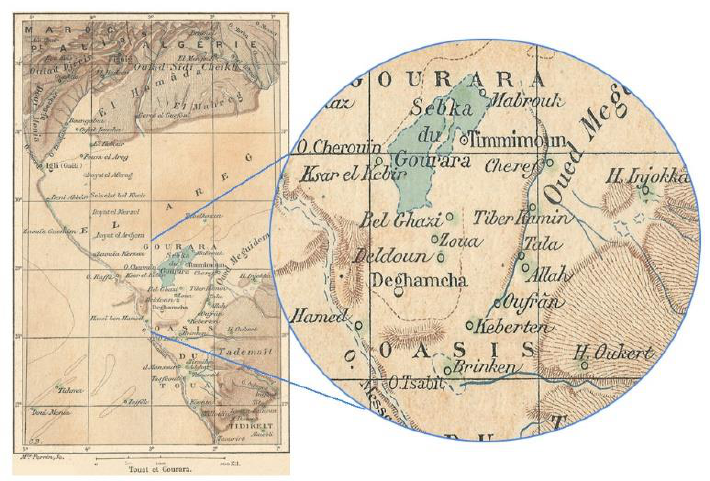
Figure 3 The map of Gourara region in the Algeria map of 1894.